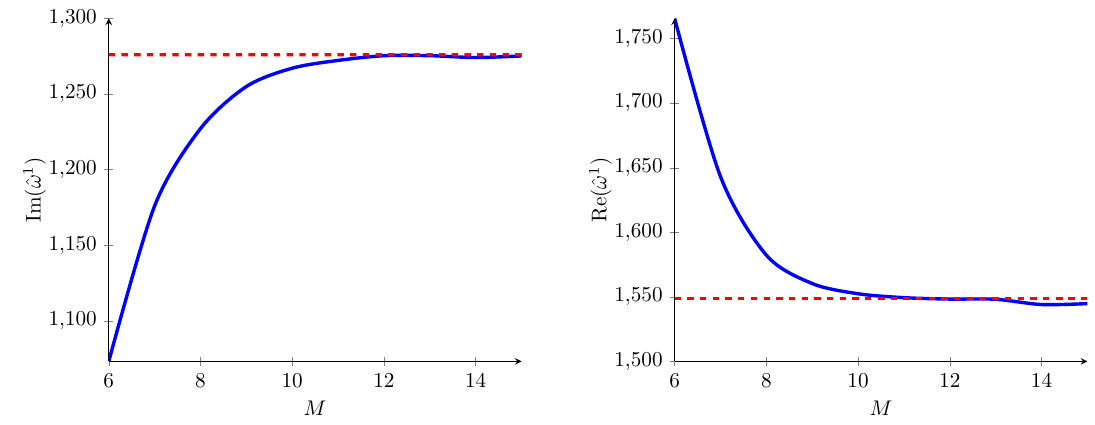
Figure 4 . The (cid:12)rst order correction ^ ! 1 to the lowest tensor-QNM frequency for b = 0, q = 0, computed via spectral methods on a grid u [0 : 1 ; 0 : 99] (solid blue line) compared with the exact 2 result (red dashed line) for di(cid:11)erent values of M shown in a smoothed